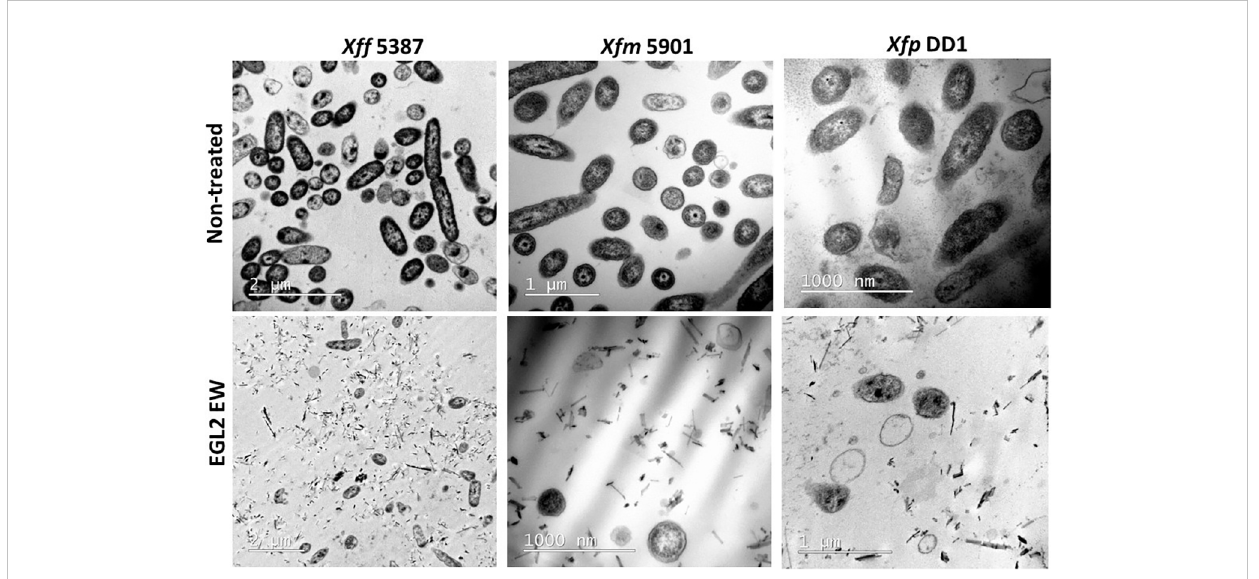
FIGURE 2 TEM microscopy of samples of of X. fastidiosa subsp. fastidiosa IVIA 5387.2, subsp. multiplex IVIA 5901.2 and subsp. pauca De Donno after exposure to EGL2 at 6 µl/ml for 120 min. Notice that very few cells remain intact after the treatment, and extensive lysis and debris material is observed (lower panels).